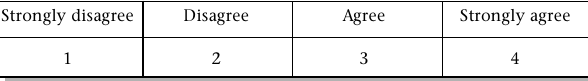
Figure 2: An example of the response scale used in